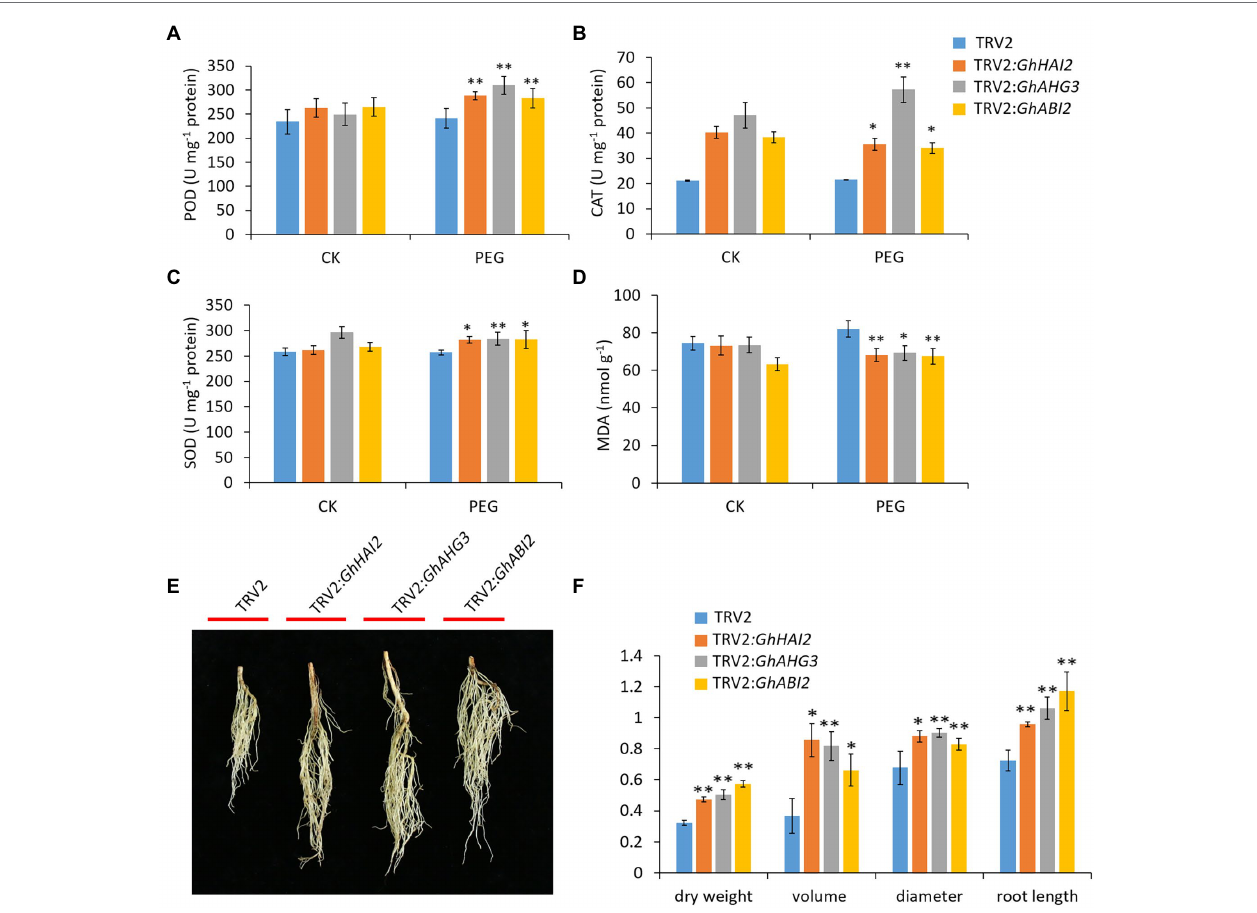
FIGURE 4 | Silencing of GhHAI2 , GhAHG3, and GhABI2 promotes ROS scavenging and increases root biomass. (A–D) Analyses of three antioxidant enzymes; SOD, POD, and CAT activities and MDA content in TRV2: GhHAI2 , TRV2: GhAHG3, and TRV2: GhABI2 and TRV2:00 plants under normal and PEG conditions. (E) Root phenotype and (F) the root dry weight, volume, diameter, and length of TRV2: GhHAI2 , TRV2: GhAHG3, and TRV2: GhABI2 and TRV2:00 plants under PEG conditions. Bars represent means ± standard deviation of three biological replicates. Asterisks represent statistically significant difference between TRV2: GhHAI2 , TRV2: GhAHG3, and TRV2: GhABI2 and TRV2:00 plants (Student’s t -test; * p < 0.05; ** p <